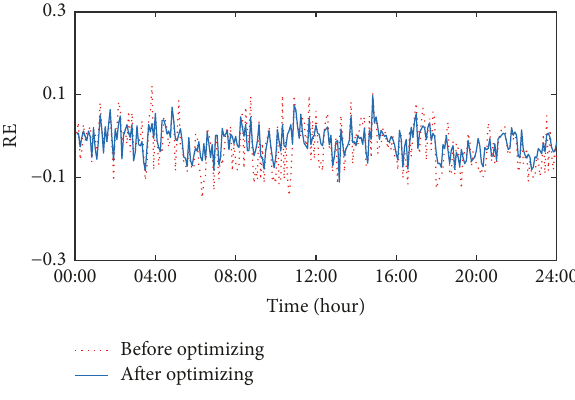
Figure 19: RE curves